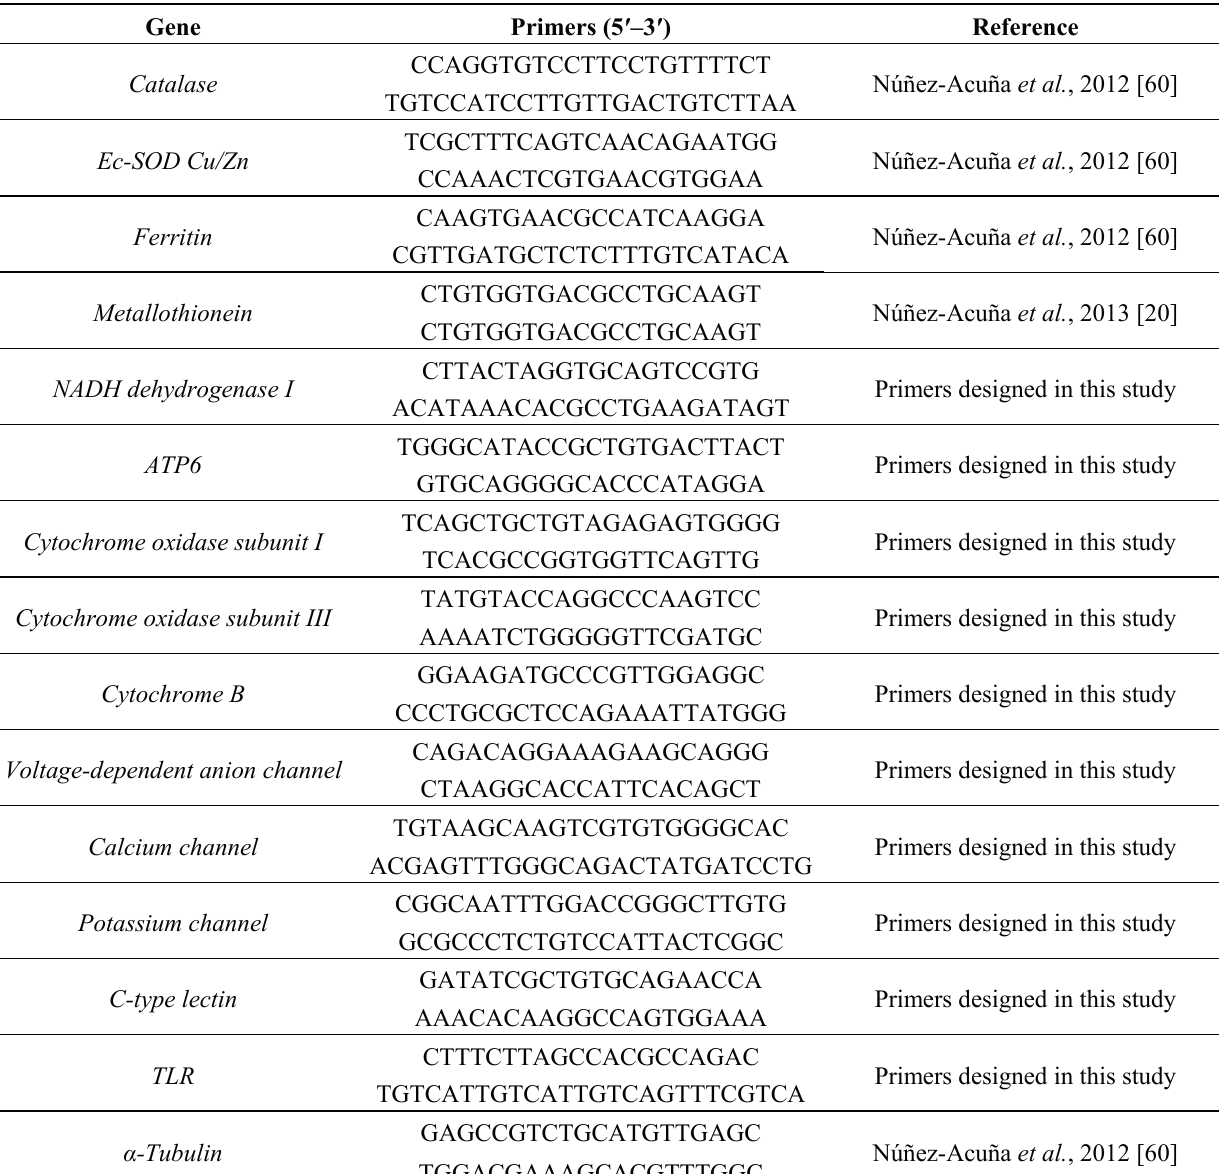
Table 1. Gene names, forward and reverse primer sequences for real-time quantitative PCR (qPCR) analysis and